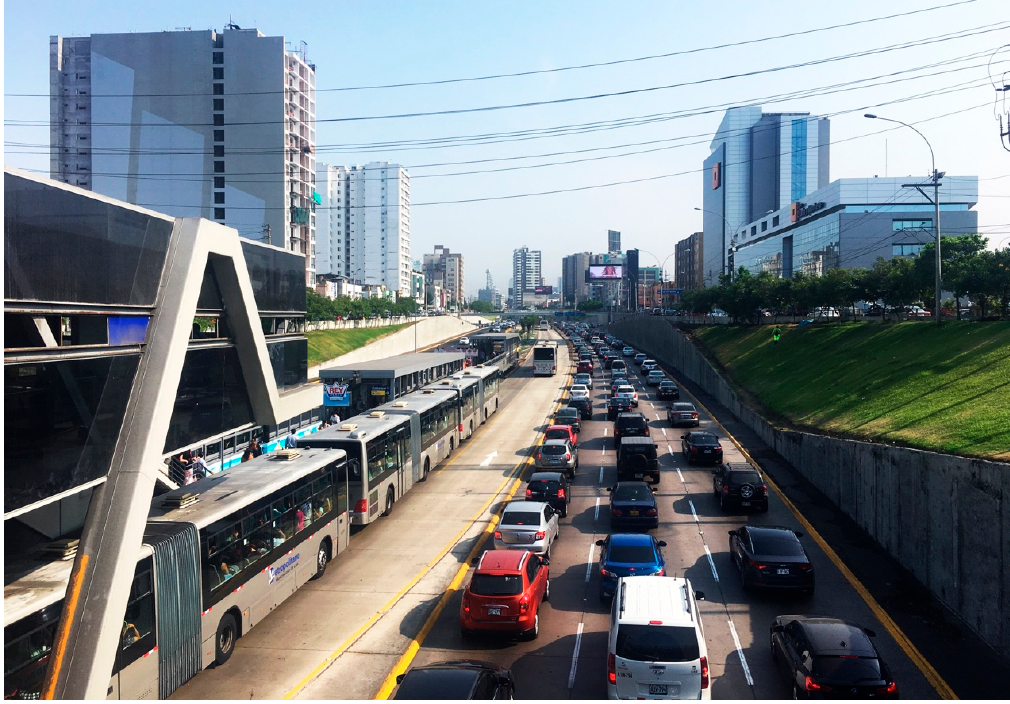
Figure 21. Traffic jam along Paseo de la República Fwy. next to the BRT lane in Central Lima. Source: Figure 21. Tra ffi c jam along Paseo de la Rep ú blica Fwy. next to the BRT lane in Central Lima. Source: Natalia Pulido (2018). Natalia Pulido